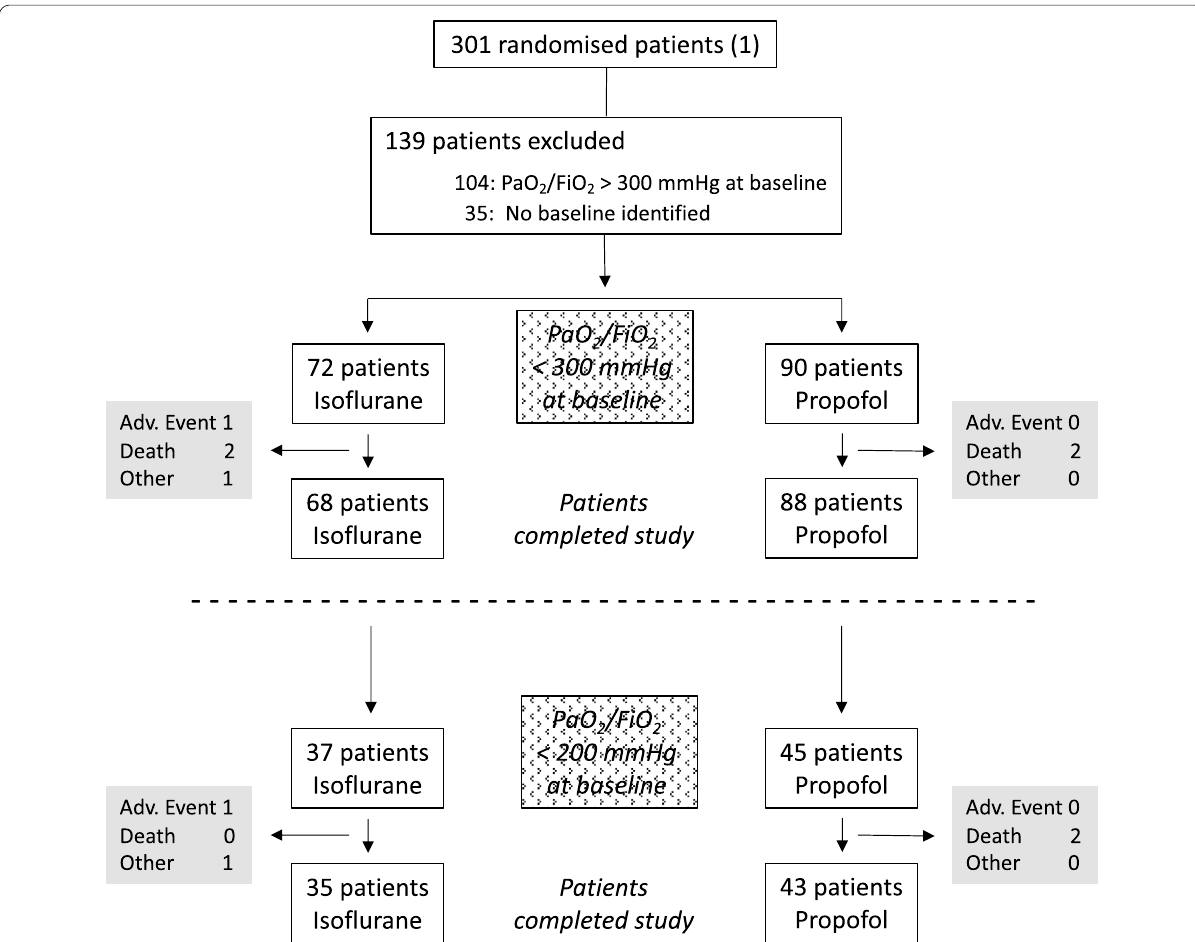
Fig. 1 CONSORT diagram. PaO 2